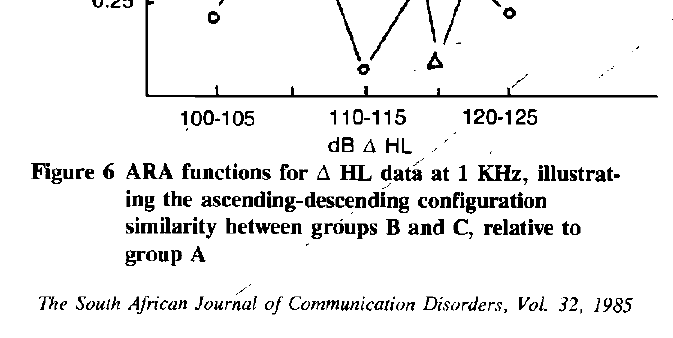
Figure 6 ARA functions for Δ HL data at 1 KHz, illustrat- ing the ascending-descending configuration similarity between groups Β and C, relative to group